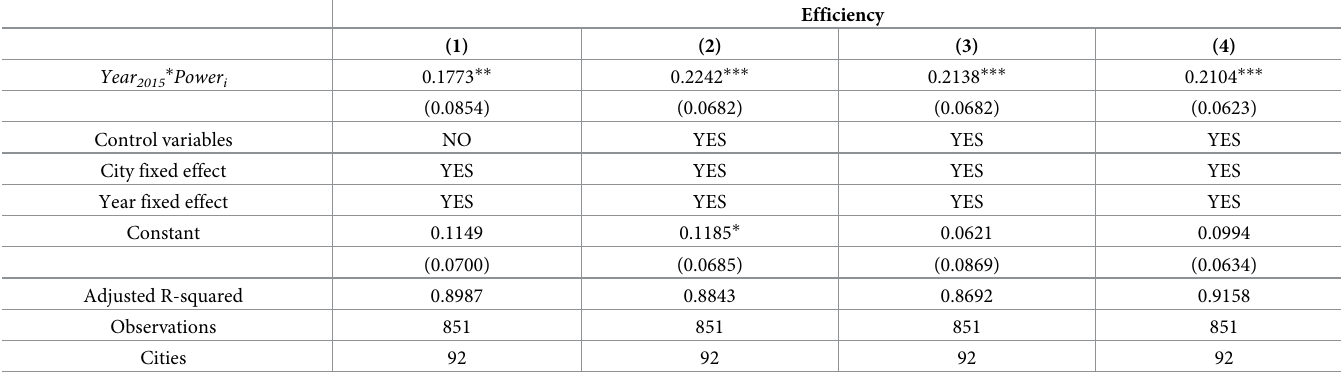
Table 8. Impact of power market reform on